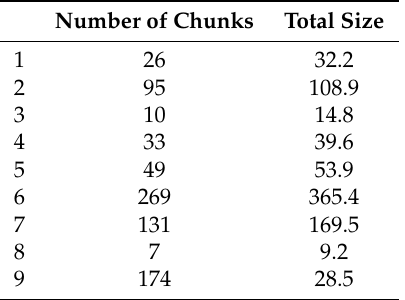
Table 1. Characteristics of the alternative collection.